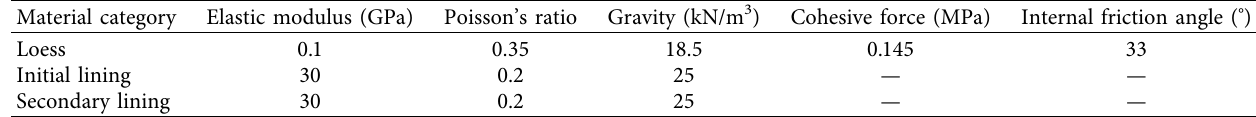
Table 1: Material parameters.